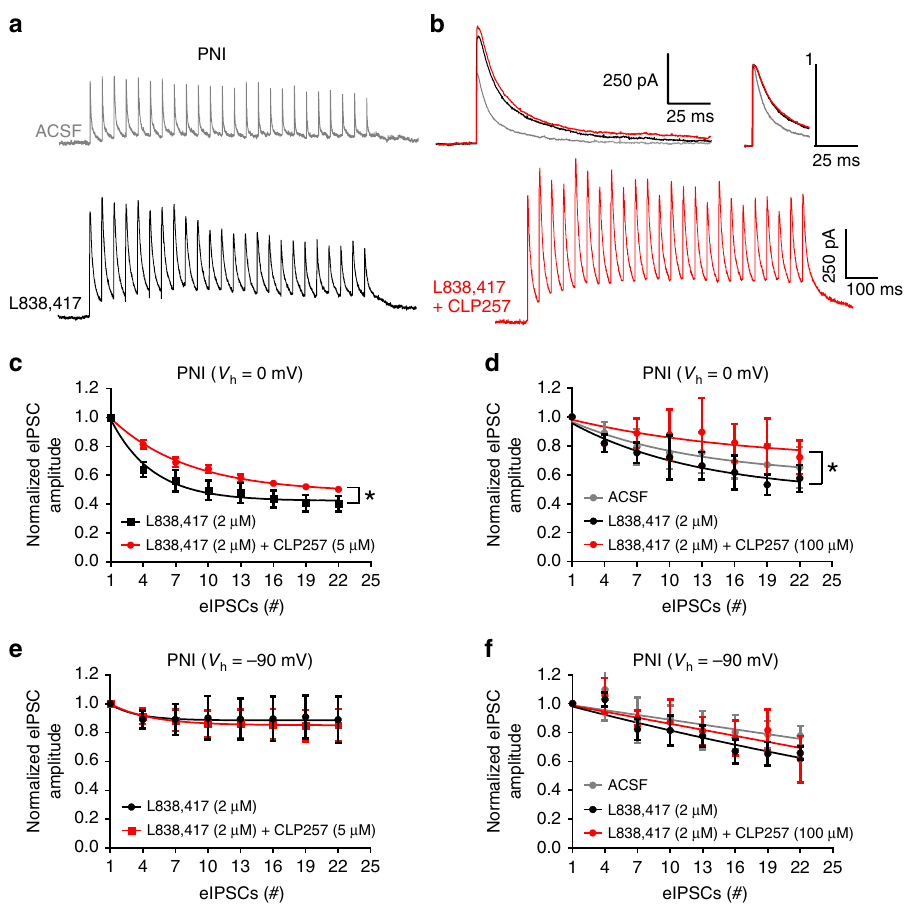
Fig. 7 CLP257 protects from dynamic collapse in Cl − gradient under a barrage of inhibitory inputs. a Three representative traces of repetitive inhibitory stimulation (20 Hz, 25 stimulations) at 0 mV in PNI, with ACSF (gray trace), with L838,417 (2 µ M, black trace) applied in the bath or with L838,417 and CLP257 (100 µ M, red trace) of transversal spinal cord sections. The depression of eIPSCs at 0 mV was ampli fi ed by L838,417 in PNI due to Cl − accumulation and can be reversed by CLP257. Stimulus artefacts have been canceled. b Representative traces showing the increase in amplitudes and decay times with L838,417 with or without CLP257 vs. ACSF on averaged eIPSCs evoked at 1 Hz. Inset shows the sames traces scaled to peak for kinetics comparison. c Averaged eIPSC amplitude depression at 0 mV during the repetitive inhibitory stimulation protocol in two pharmacological conditions: L838,417 (2 μ m) and L838,417 (2 μ m) + steady-state of CLP257 (5 μ M) incubations (one phase decay fi ts; n = 5 neurons per condition). d same stimulations and recording conditions with at least 15 min of pre-incubation of the following conditions: ACSF, L838,417 (2 μ m), L838,417 (2 μ m) + CLP257 (100 μ M) (one phase decay fi ts; n = 3 to 4 neurons per condition). e same as c with a holding potential of − 90 mV instead of 0 mV. f same as d with a holding potential of -90 mV instead of 0 mV. eIPSC amplitude were normalized to the average of the fi rst three eIPSCs generated by the 20 Hz stimulation. (* P < 0.05). Source data is available as a Source Data fi